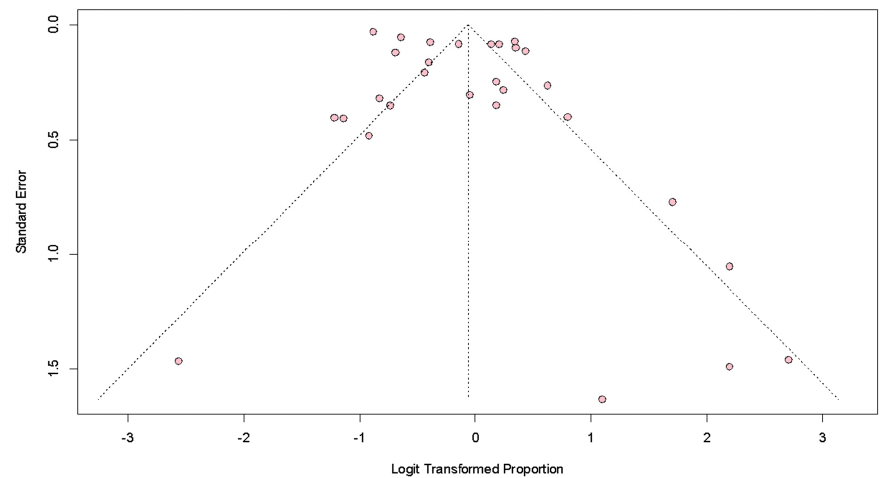
Figure 2. Funnel plot for pathological complete response across the nine studies. p ‐ value for publication bias = 0.02. The median cut ‐ off value for the HER2/CEP17 ratio was 5.0 ± 5.0 (min ‐ max = 1.0